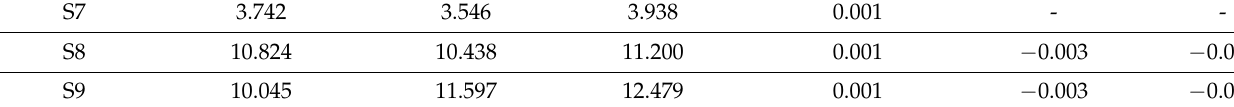
Table 8. SLSTR A and SLSTR-B Band Centres, Short and Long Wavelength edges, estimated uncertainties in positions from measurements and temperature sensitivity of the band edges.